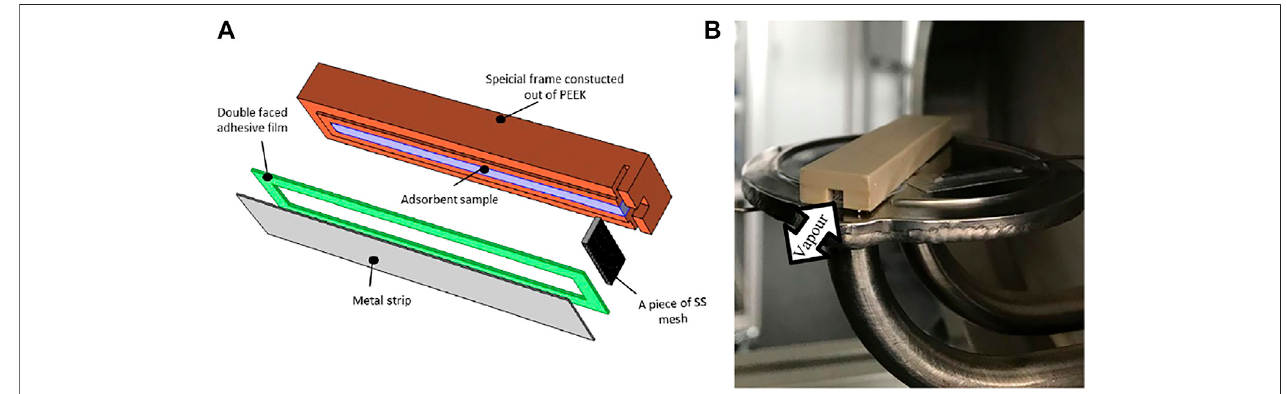
FIGURE 5 | Adsorption kinetic (upper) and vapour pressure (lower) curves of the APHE (full-scale measurements) and its representative adsorbent sample (small- scale measurements) at evaporator, condenser/adsorption-end and desorption temperatures of (A) 15/30/90 ° C, (B) 15/35/90 ° C, (C) 10/30/90 ° C, (D) 10/35/90 ° C.